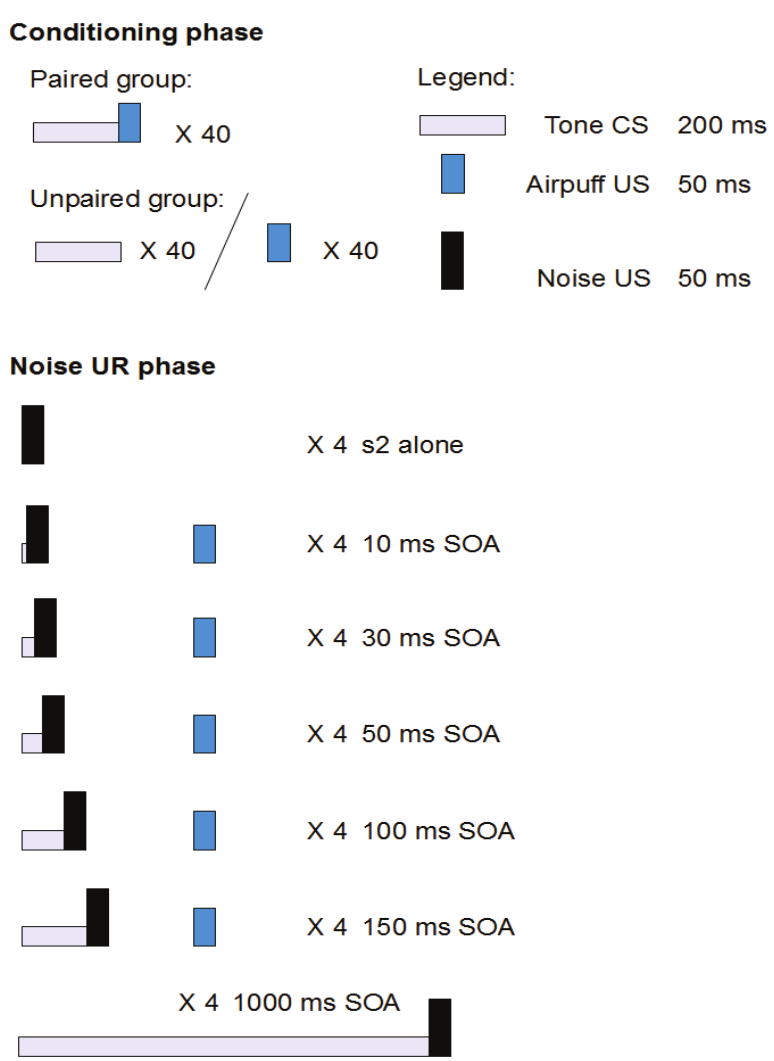
Figure 1. A schematic presentation of the experiment